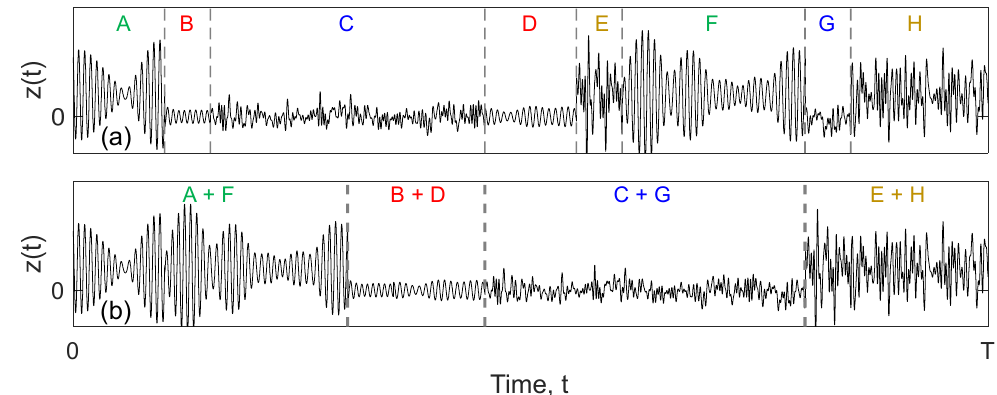
Figure 1. Example of state reordering: ( a ) nonstationary switching time history with replicated stationary states; ( b ) the same time history after state reordering.